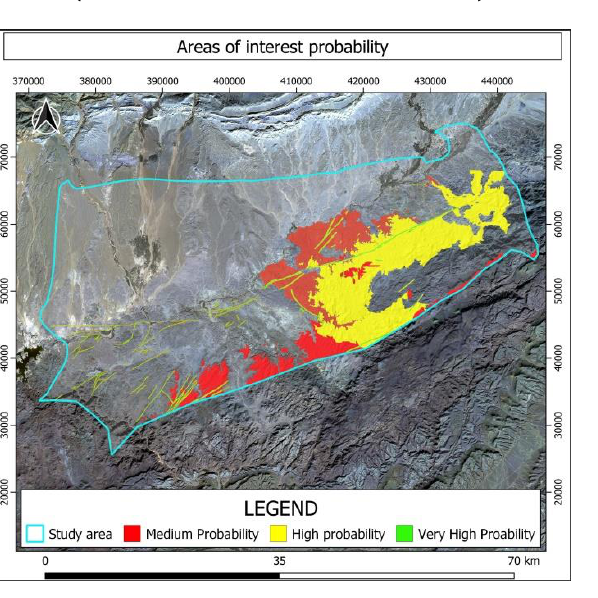
Table 2: Random Forest classification